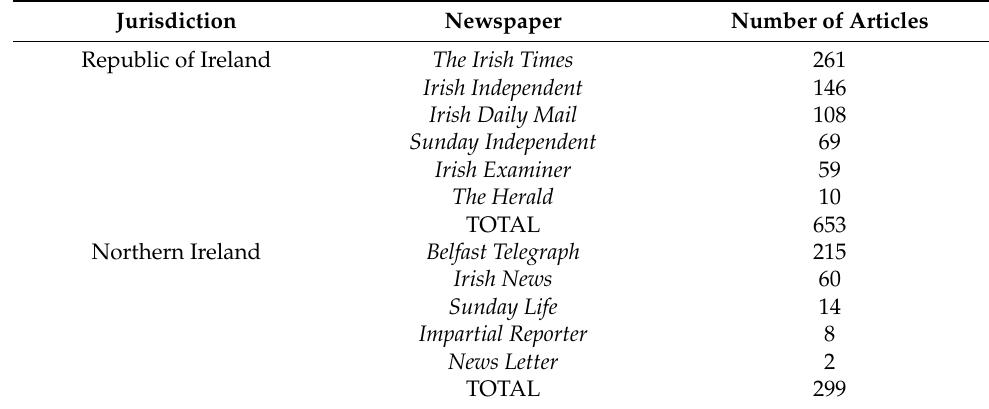
Table 1. Frequency of articles from the newspapers included in the